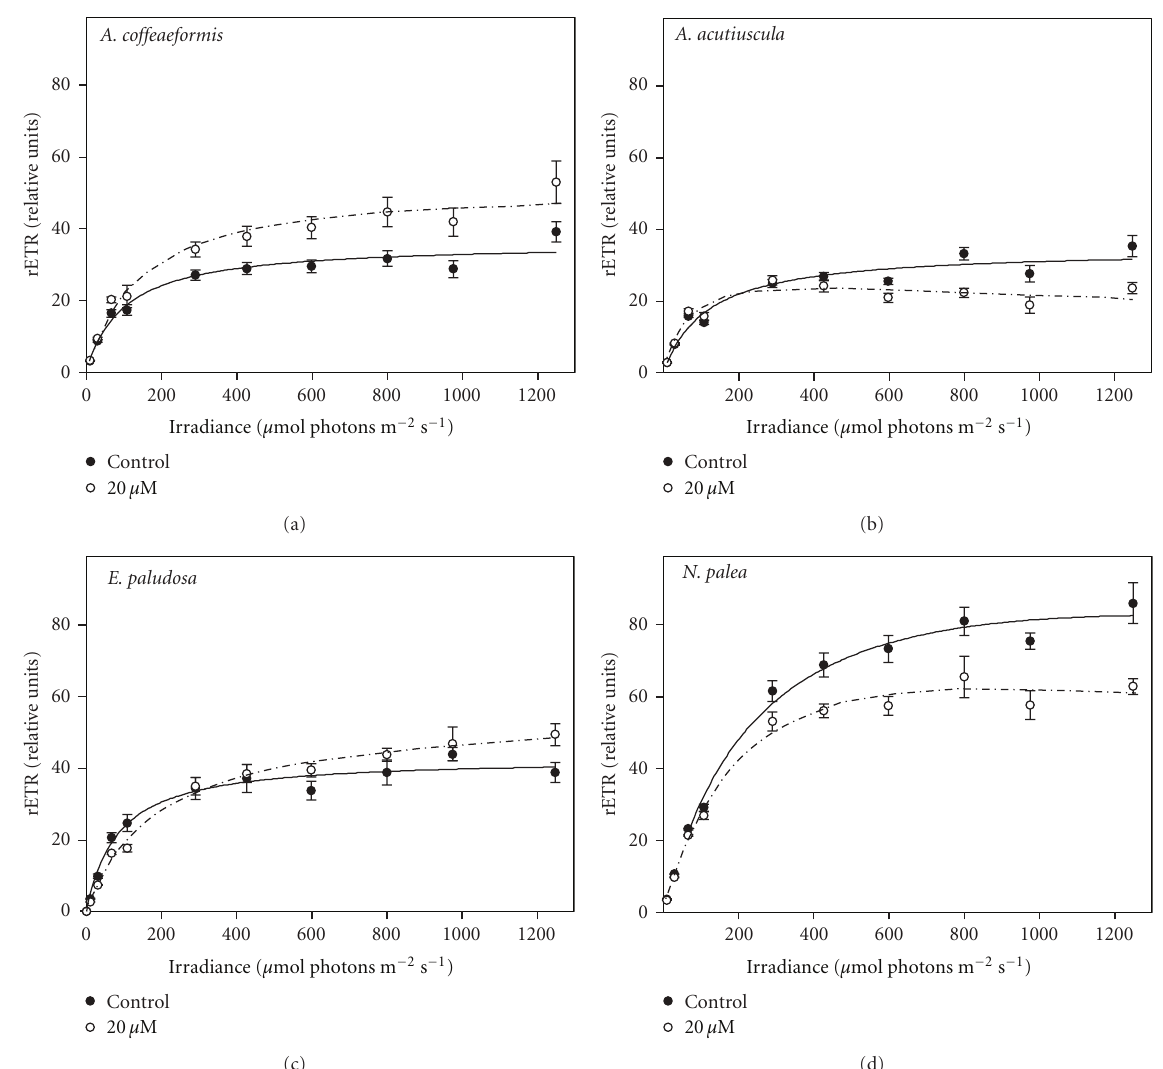
Figure 3: Relative electron transport rate (rETR) versus irradiance curves in Amphora co ff eaeformis , Amphora acutiuscula, Entomoneis paludosa, and Nitzschia palea grown in ASW (control) or in the presence of 20 μ M Zn added to ASW. Mean values ± SE ( n =